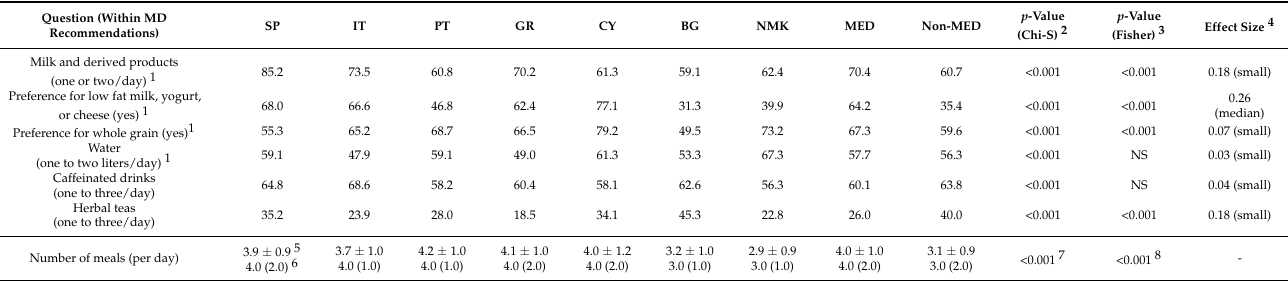
Table 3. Preferences of the sample population in each country for the remaining food-related questions of the MeDiWeB questionnaire. Percentage of participants scoring the indicated quantity. SP: Spain; IT: Italy; PT; Portugal; GR: Greece; CY: Cyprus; BG: Bulgaria; NMK: Republic of North Macedonia. MED: all Mediterranean countries together; Non-MED: all non-Mediterranean countries